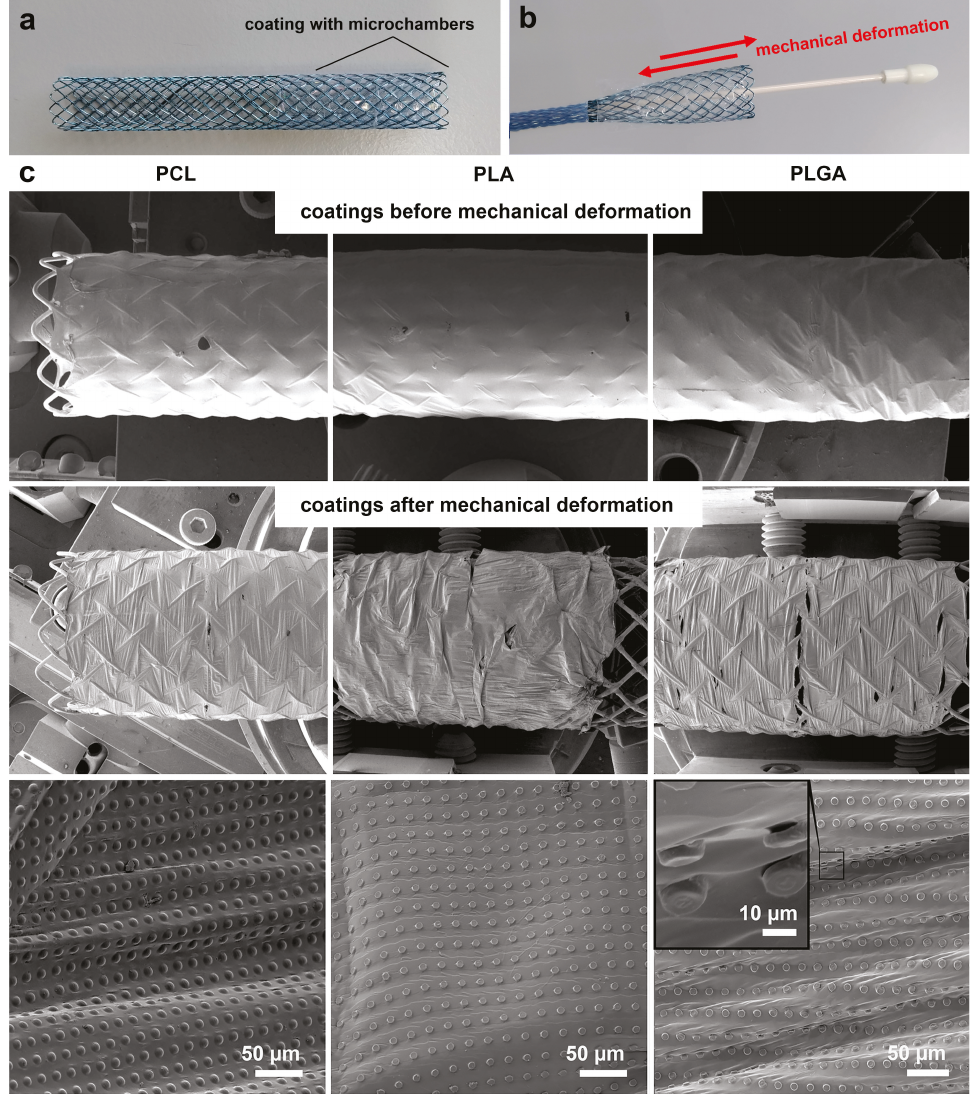
Figure 3. Typical photo of the stent with a coating based on microchamber arrays before ( a ) and after deformation in a delivery system ( b ). Stent size, 60 microchamber arrays based on PCL, PLA, and PLGA before and after deformation in a delivery system ( c ).